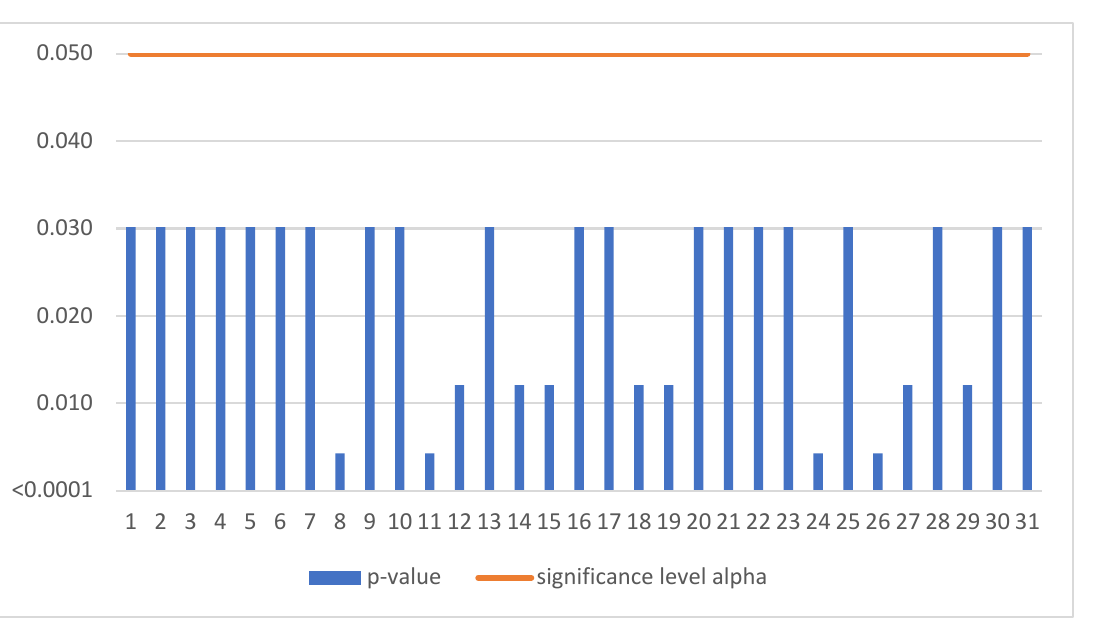
Figure 2. No trend in Slovakia.